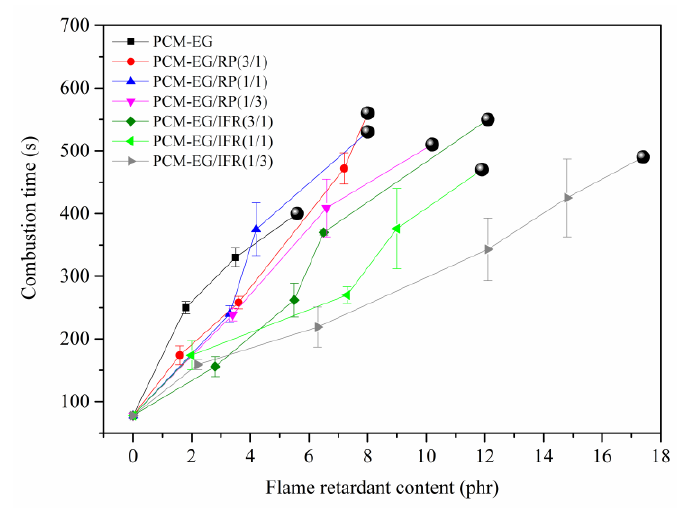
Figure 1. Horizontal burning results of paraffin-based shape-stabilized phase change materials (SSPCMs) coated with different flame retardants ( : self-extinguish).